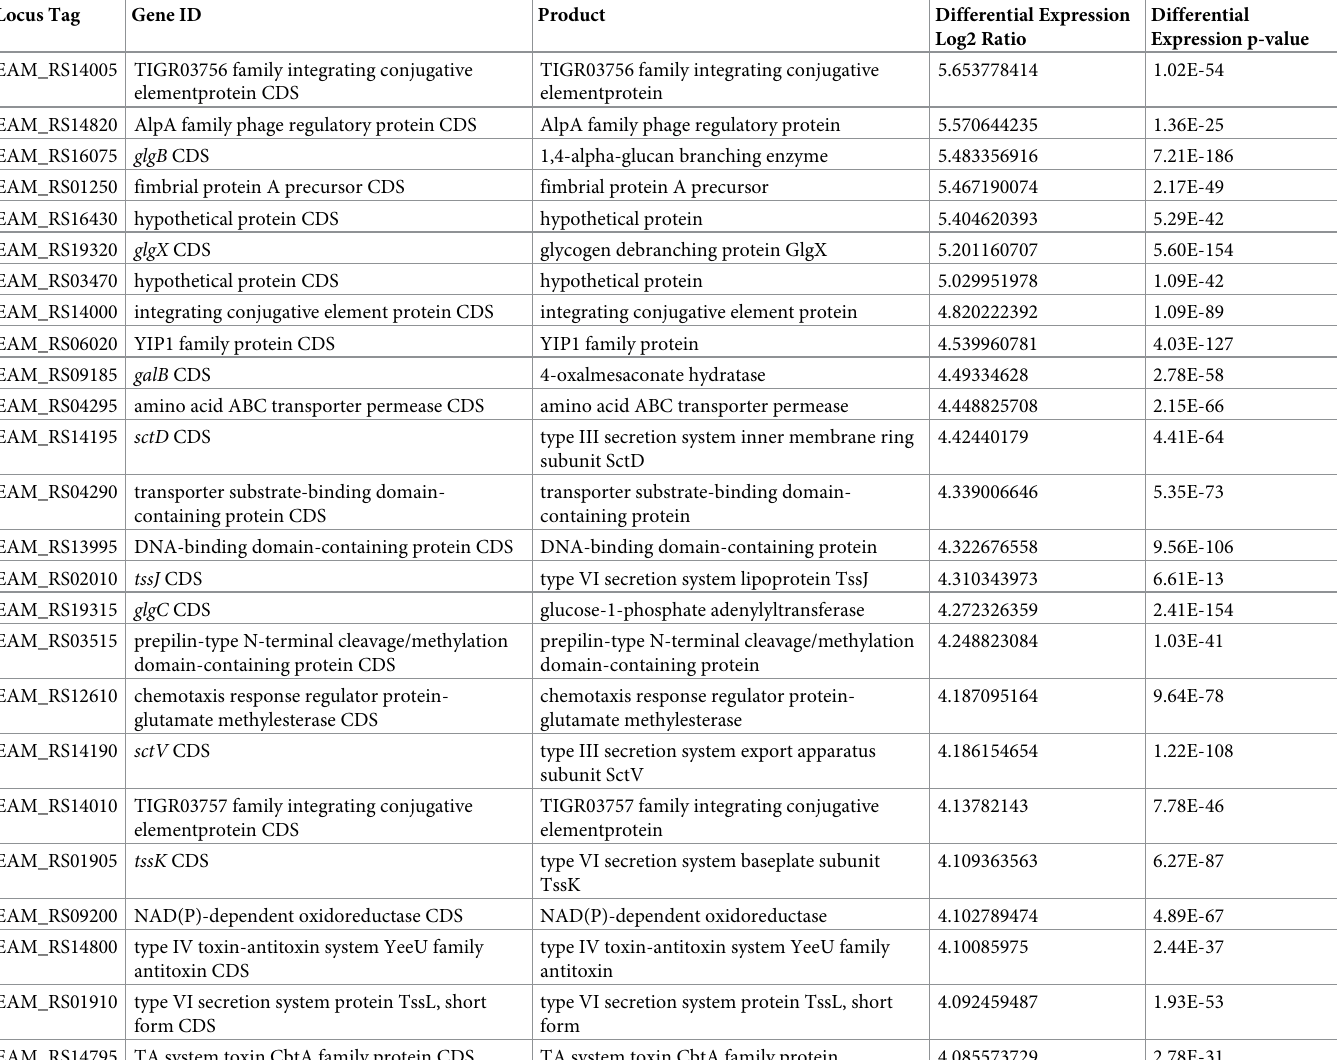
Table 2. A list of the 25 most positively regulated genes in Ea1189 Δ 12 relative to WT